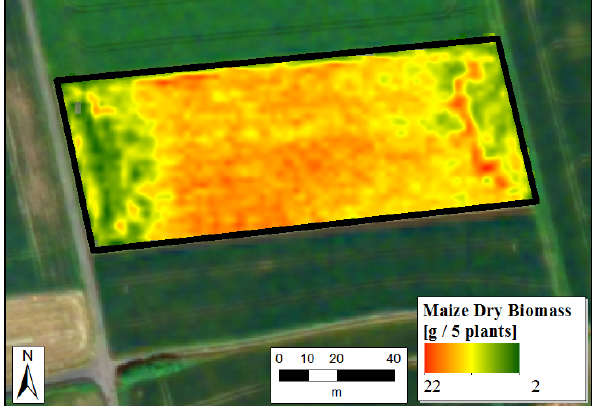
Figure 11. Final dry biomass Map for the 2 nd date (07.07.2013), calculated from WorldView-2 NDVI and CSM derived plant height using formula 1. Background: Pansharpened WorldView-2 image from 8 th